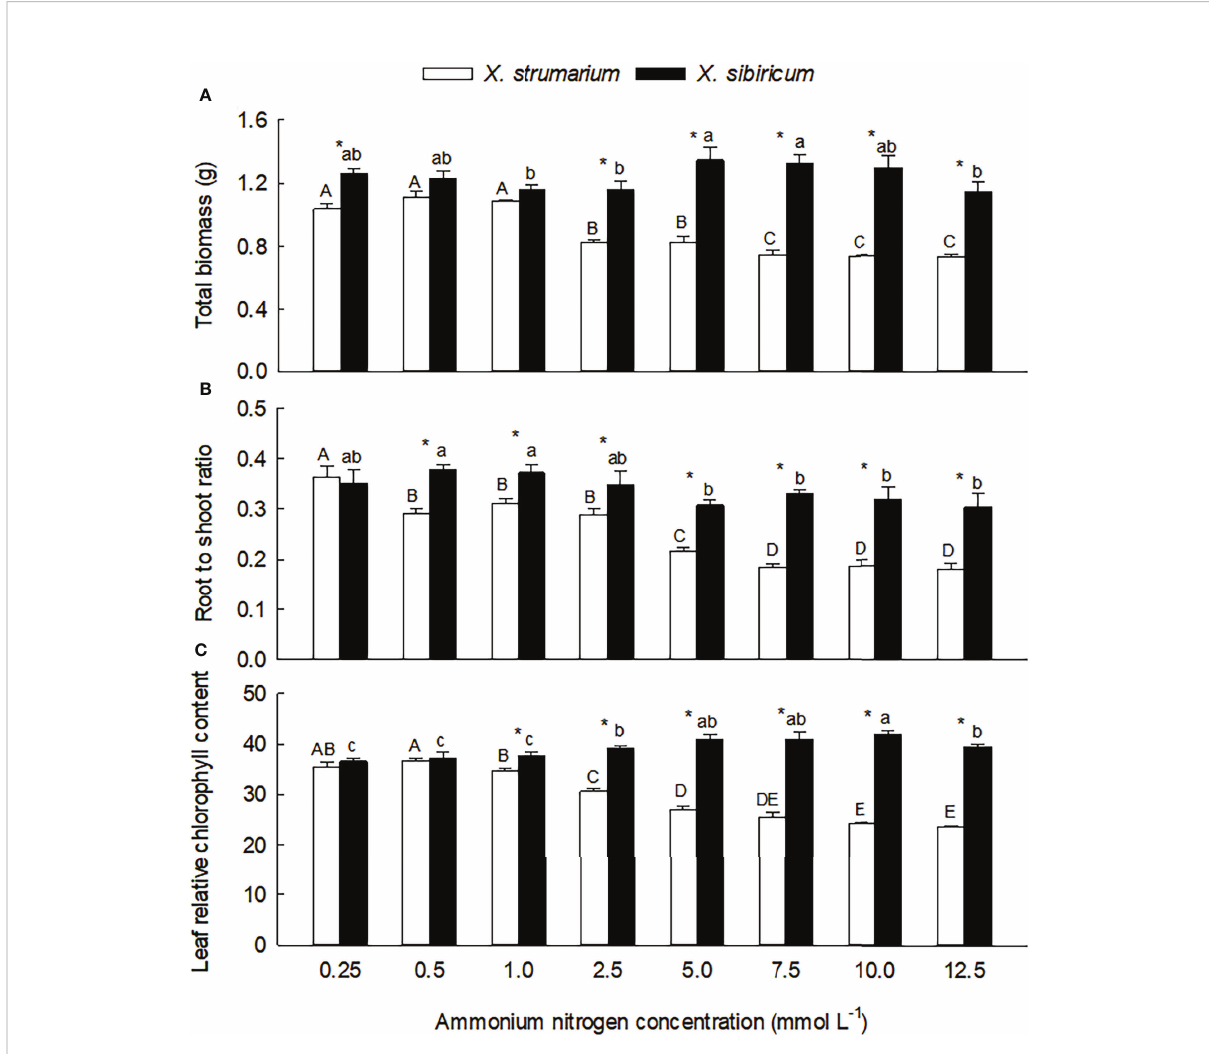
FIGURE 1 Differences in total biomass (A) , root to shoot ratio (B) and leaf relative chlorophyll content (C) between the invasive plant Xanthium strumarium and its native congener X. sibiricum under different ammonium levels. Means + 1 SE ( n = 6). Different upper- and lowercase letters indicate signi fi cant differences among ammonium treatments for X. strumarium and X. sibiricum , respectively ( P < 0.05; one-way ANOVA); * indicates signi fi cant difference between the two species under the same ammonium treatment ( P < 0.05; independent sample t -test). See Table S1 for the results of two-way